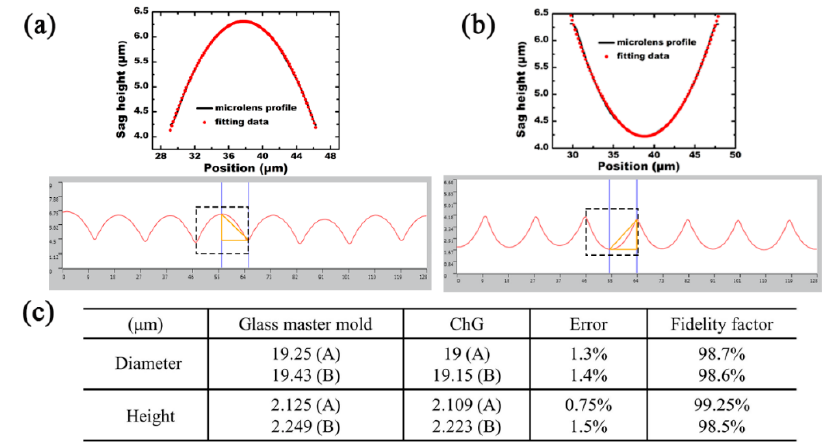
Figure 5. ( a ) The cross-section of the convex MLAs; ( b ) the cross-section of the concave MLAs; insets in ( a , b ) are the enlarged view of the data in the box and its profile fitting; ( c ) the fidelity factor of the convex MLAs.